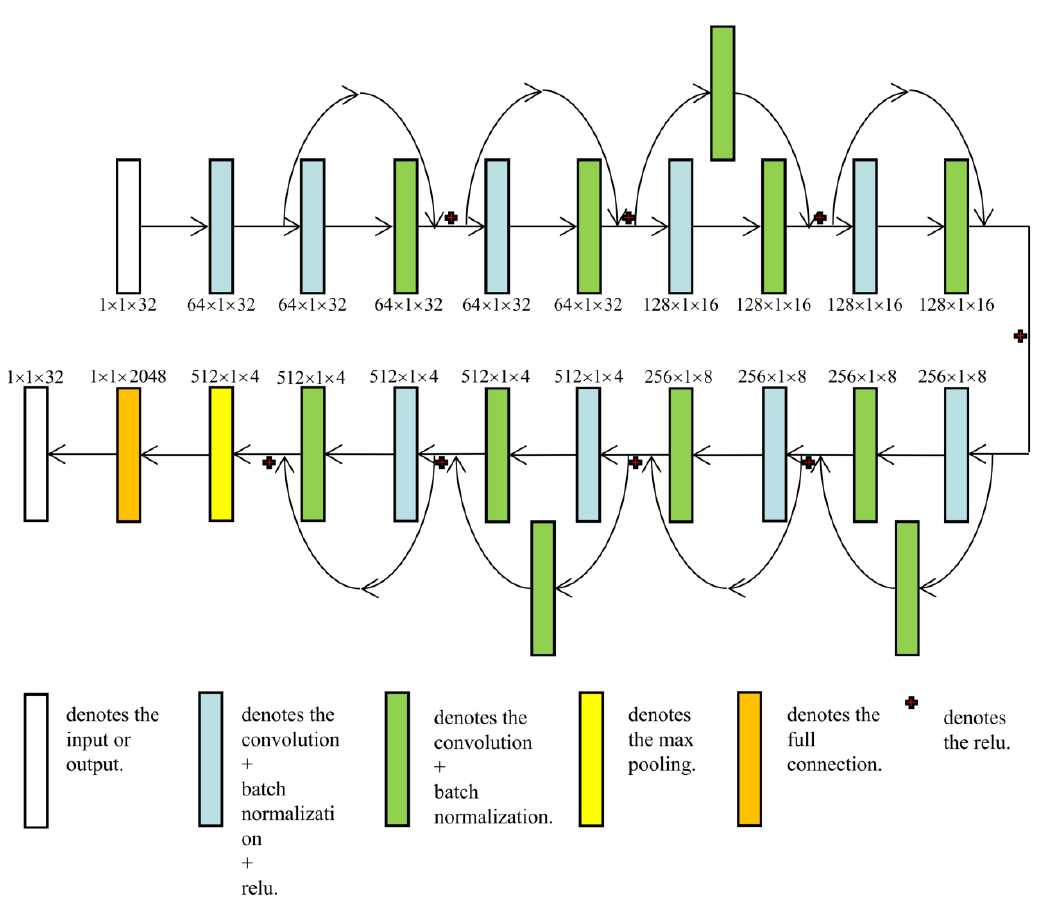
Figure 2. The architecture of the ResNet for MT noise identification and suppression.